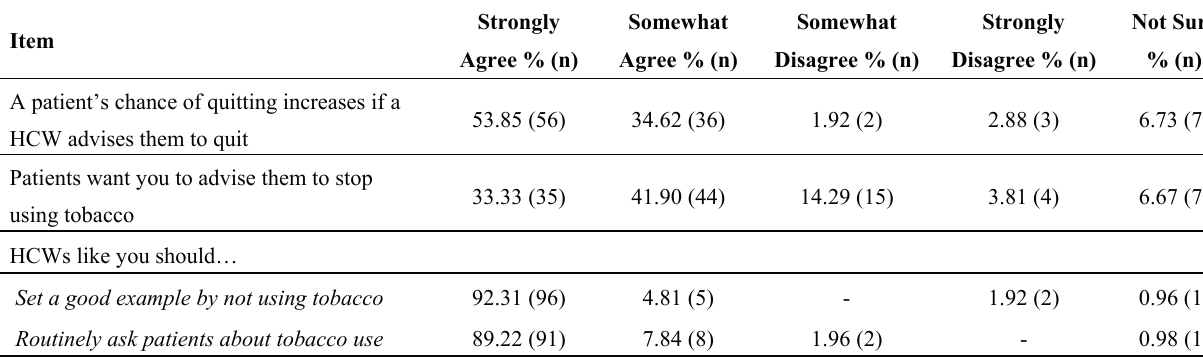
Table 3. Health care workers’ attitudes and behaviors on tobacco use advising